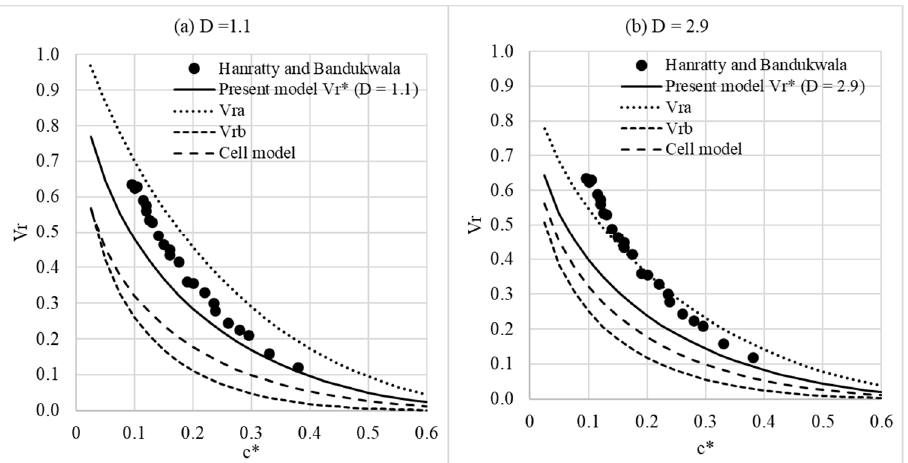
Figure 1. Comparison with early experimental data from typical runs of Hanratty and Bandukwala [13] for both the sedimentation and fluidization of steel spheres and glass spheres with ( a ) D = 1.1 and ( b ) D = 2.9. In ( a ) and ( b ), Vra = Vr* + s and Vrb = Vr* - s.